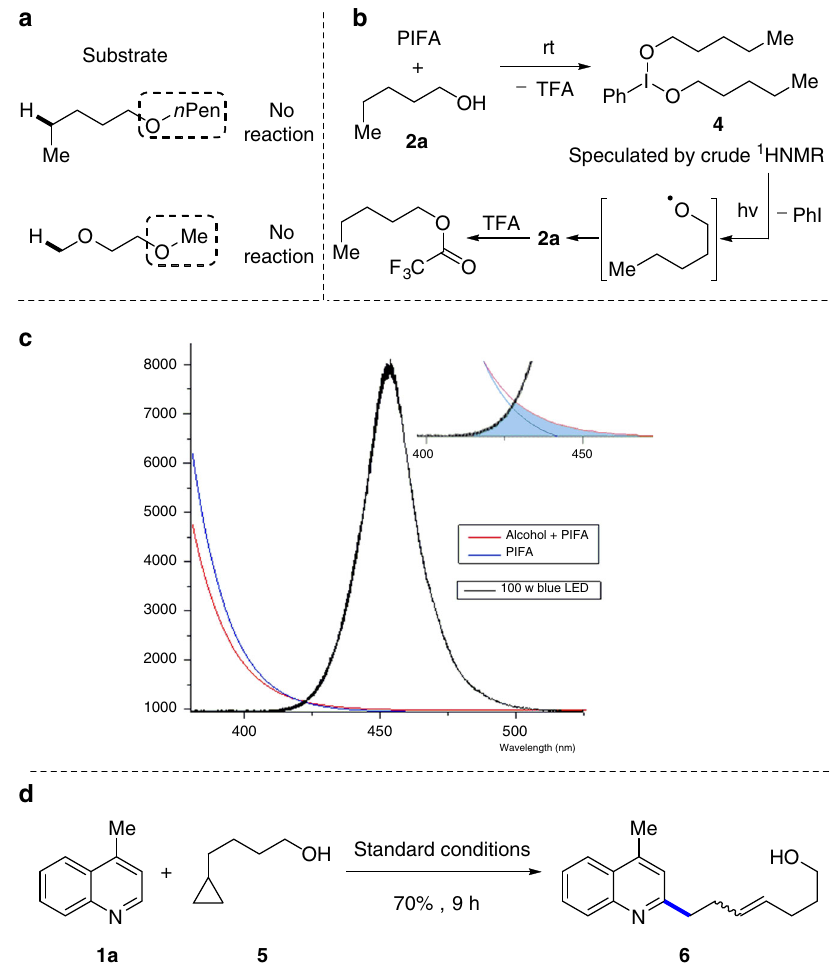
Fig. 3 Mechanistic studies. a Reaction with ethers instead of alcohols. b NMR studies for mechanistic investigation. c Absorption spectra (PIFA and 4 ) and emission spectra (blue LEDs). d Radical clock experiment. PIFA: phenyliodine bis(tri fl